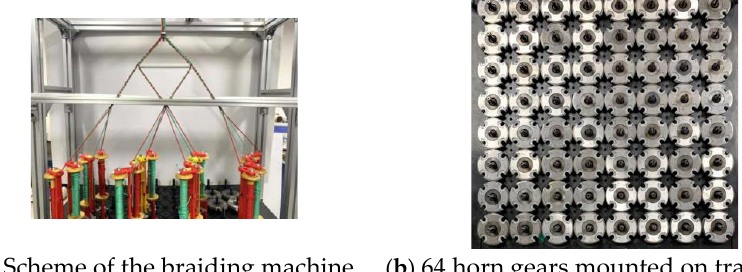
( b ) 64 horn gears mounted on track disc. Figure 7. Three ‐ dimensional square rotary braiding machine [24]. Figure 7. Three-dimensional square rotary braiding machine